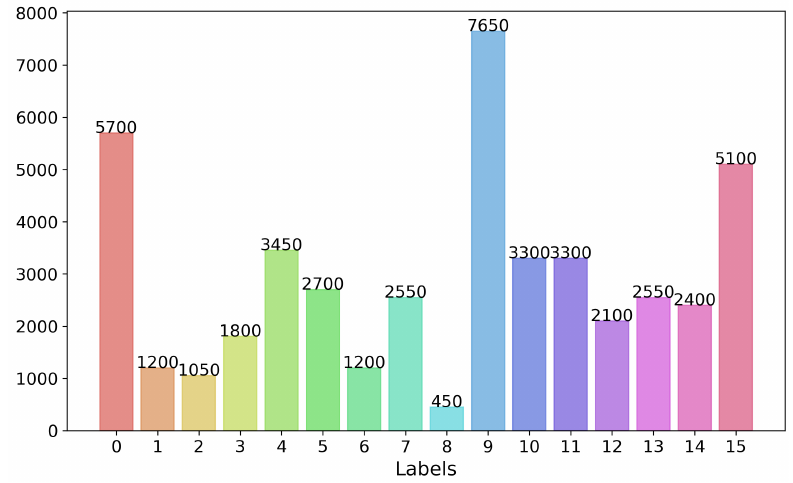
Figure 8. Data distribution for pest classification in mango farms dataset. Labels are assigned in alphabetical order.